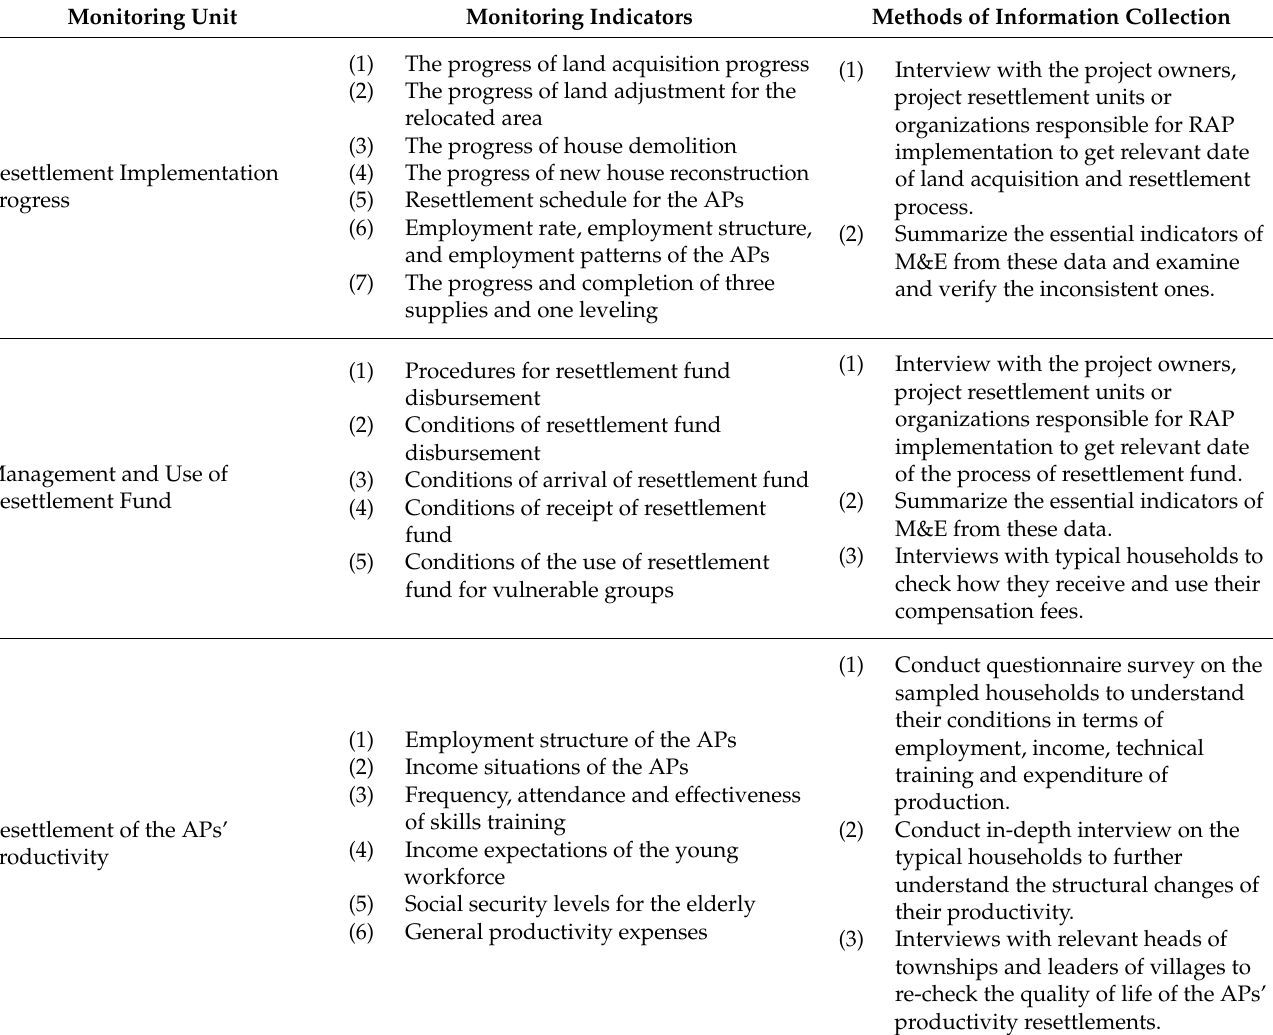
Table A1. Summary of the Current Monitoring Model of